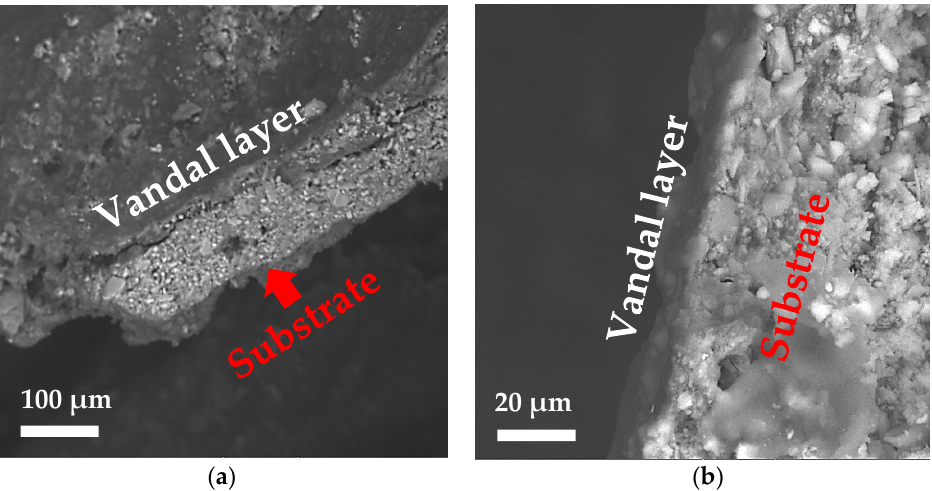
Figure 7. SEM images of samples coated with 3 applications of ( a )PRO-ART and ( b ) AG09W and vandalized with black acrylic paint.